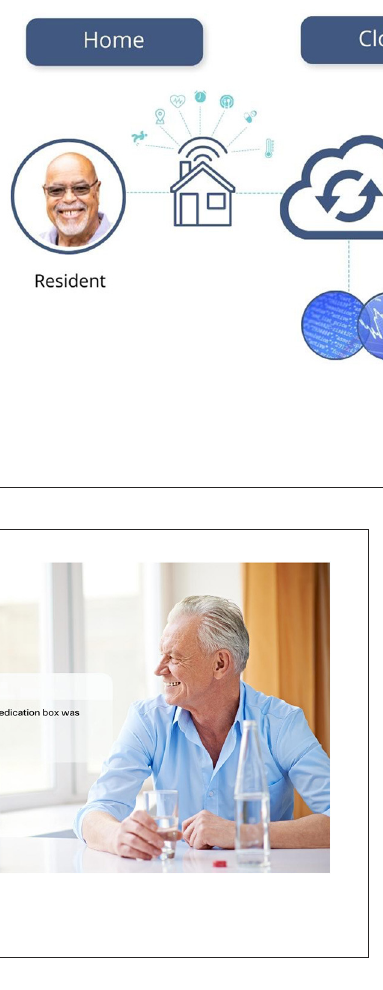
FIGURE8 Safe and